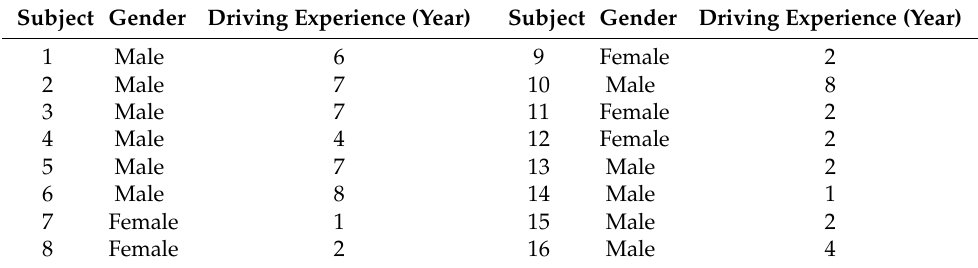
Table 1. Fundamental information of subjects.